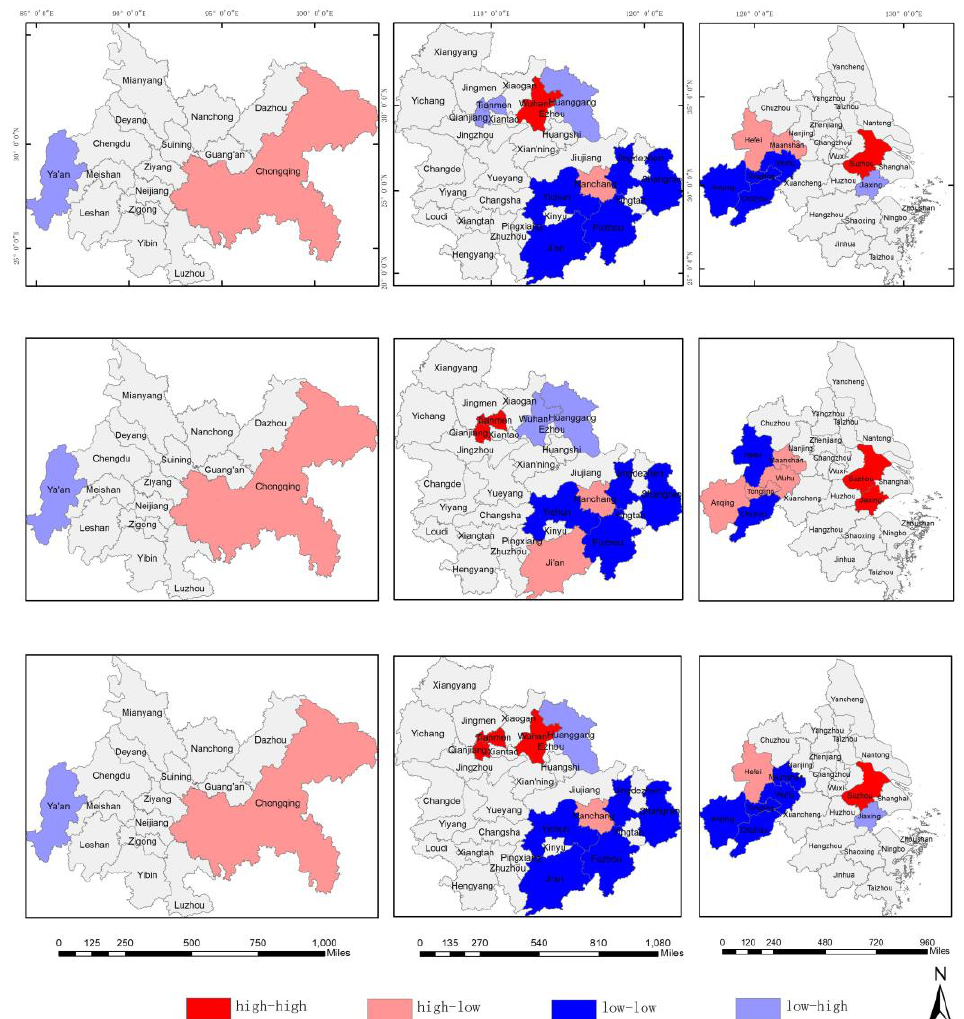
Figure 4. Spatial correlation analysis of urbanization and WEF. Note: The top, middle, and bottom three sub-figures represent the result of population urbanization, economic urbanization, and land urbanization, respectively. For each of three sets of sub-figures, from the left to the right are the three urban agglomerations of Chengdu–Chongqing, the Middle Yangtze River, and the Yangtze River Delta.